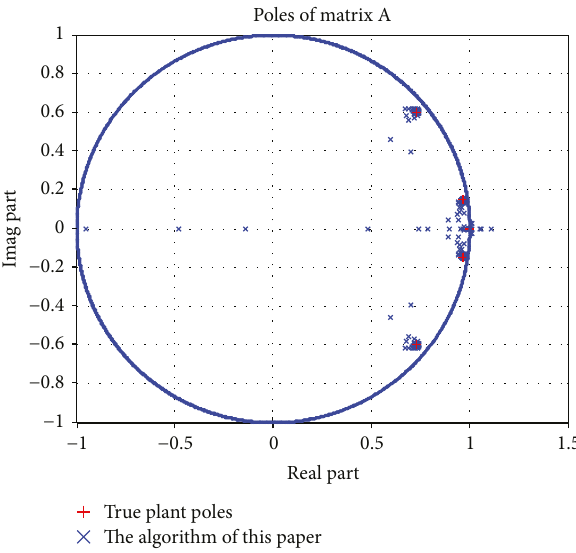
Figure 9: The algorithm of this paper simulation and comparison of root